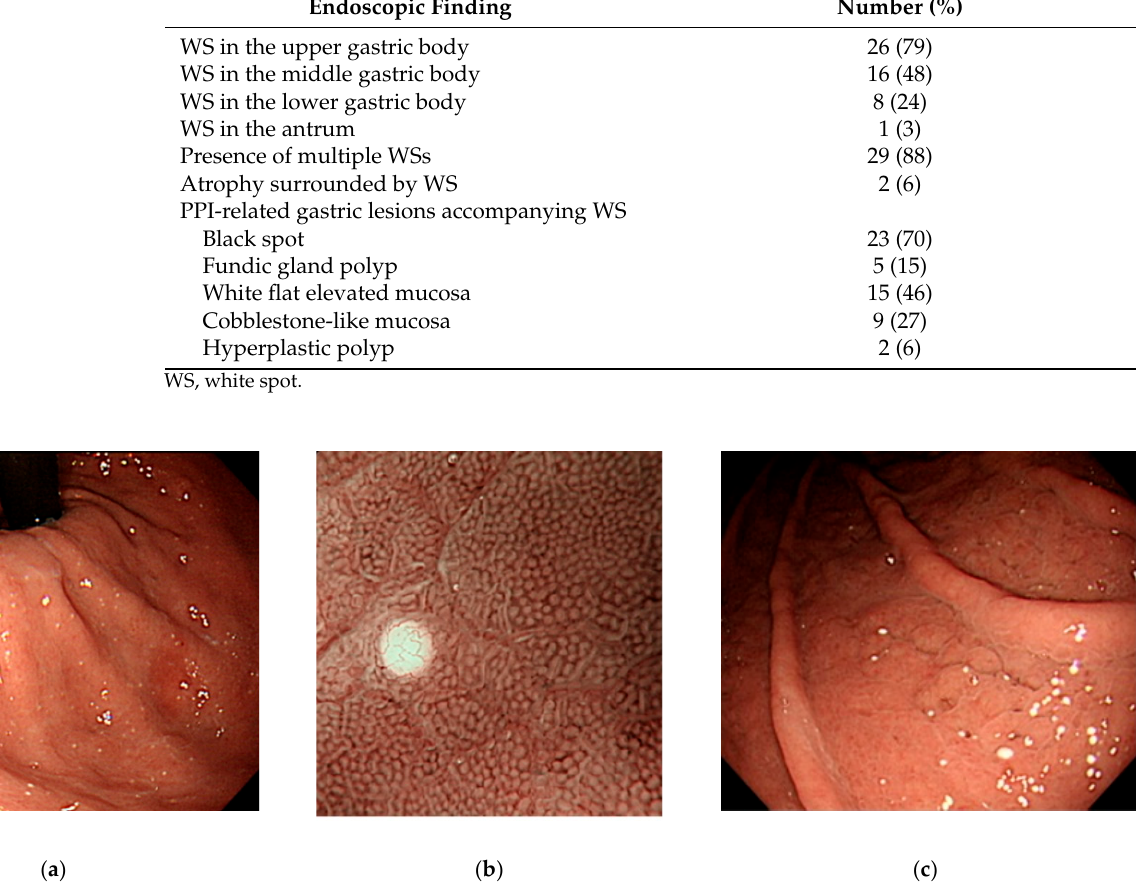
Figure 5. Endoscopic images of white spot: ( a ) multiple white spots at the fornix of the stomach; ( b ) nonatrophic mucosa with a round pit surrounded by white spot on magnifying narrow-band imaging; ( c ) gastric-cracked mucosa (a proton- pump-inhibitor-related lesion) in a patient with white spot.